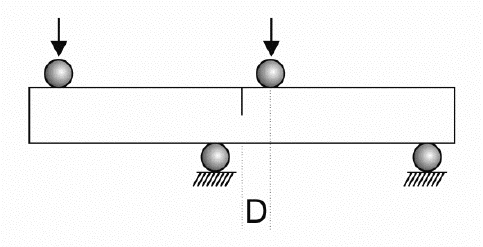
Figure 2. Geometry of the asymmetric four point bending fixture.